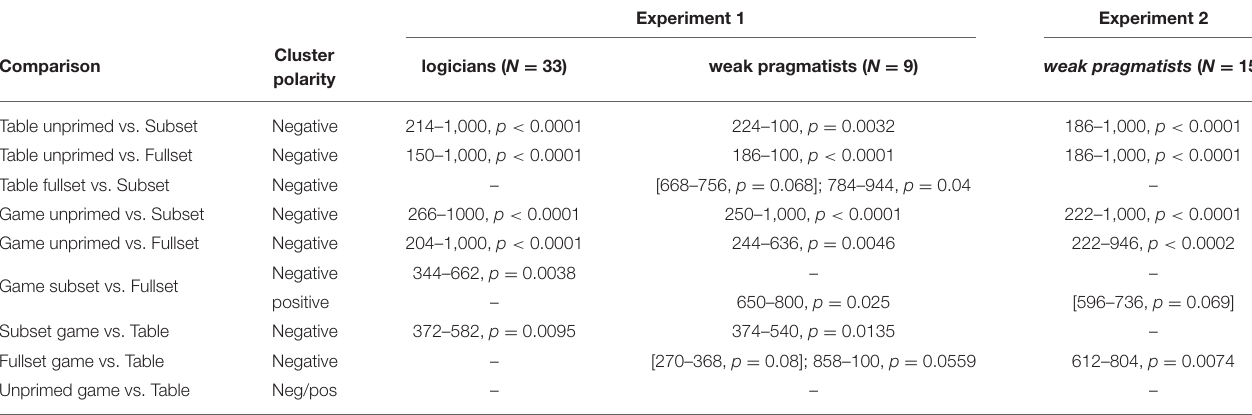
TABLE 5 | The results of the cluster-based statistics for all comparisons: the temporal extension of the respective observed cluster (in ms) as well as its p-value evaluated by the permutation test.